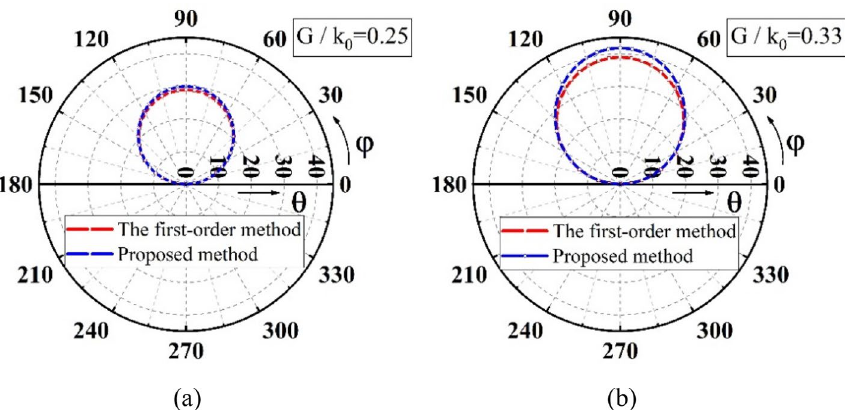
Figure 6. Comparisons for the beam trajectory when ψ 1 = 90 ◦ and ψ 2 varies from 0 ◦ to 360 ◦ . ( a ) G/ k 0 = 0.25 ; ( b ) G/ k 0 = 0.33